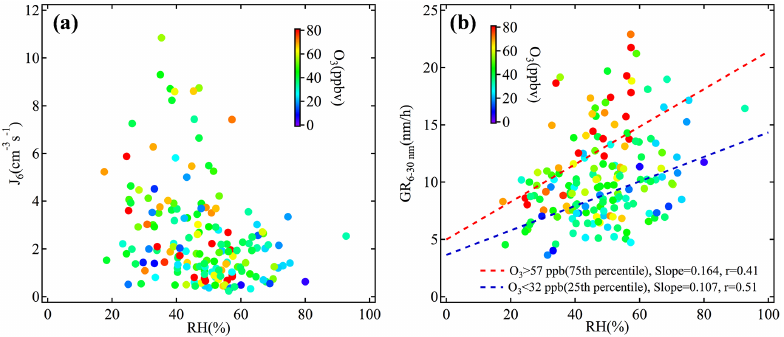
Figure 10. Scatter plot (a) between J 6 and RH and (b) between GR 6–30nm and RH, color coded with O 3 concentration. Note: linear fits for the data when the O 3 concentration is higher than 57ppbv (the 75th percentile) or lower than 32ppbv (the 25th percentile) are shown in Fig. 10b, respectively. Table 4. Correlation coefficients of J 6 and GR 6–30nm with the main meteorological parameters and air pollutants. Temp. RH Radiation O 3 PM 2 . 5 SO 2 NO x CS ( ◦ C) (%) (Wm − 2 ) (ppbv) (µgm − 3 ) (ppbv) (ppbv) (10 − 2 s − 1 ) J 6 (cm − 3 s − 1 ) 0.10 − 0.31 ∗ 0.32 ∗ 0.17 ∗ 0.01 0.11 0.06 GR 6–30nm (nmh − 1 ) 0.36 ∗ 0.27